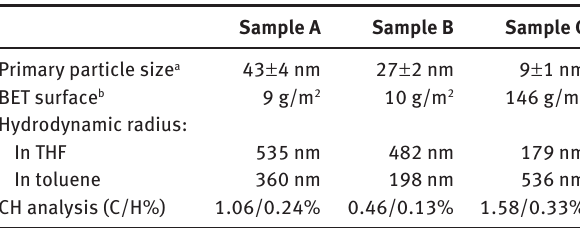
Table 1 Analytical data for the as-synthesised GeO (samples A – C